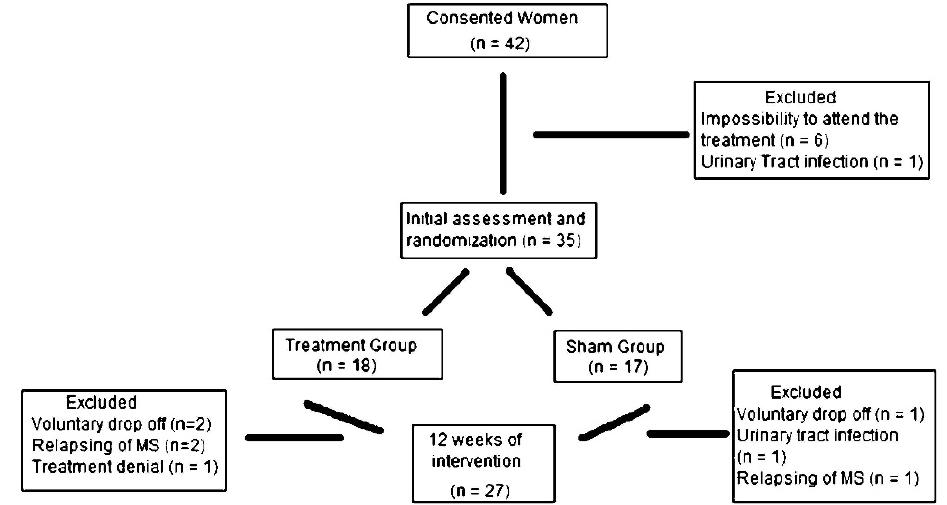
Figure 1 - The excluded patients throughout the